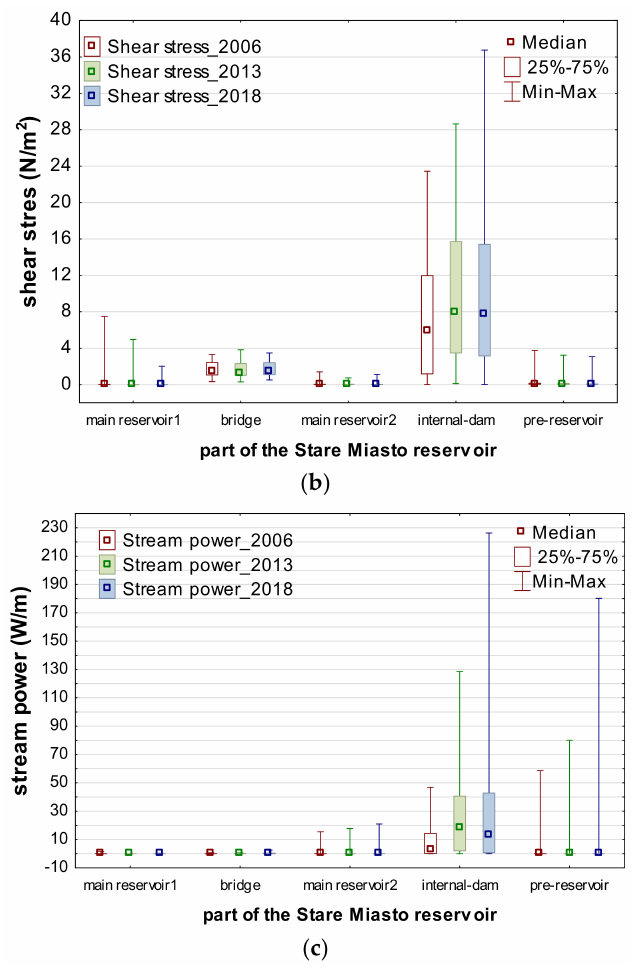
Figure 14. Characteristic values of analyzed hydraulic parameters simulated for bathymetries 2006, 2013, and 2018, and recorded at random points: ( a ) Velocity; ( b ) shear stress; ( c ) stream power. It is also important that there is a difference in trend between the median and maximum